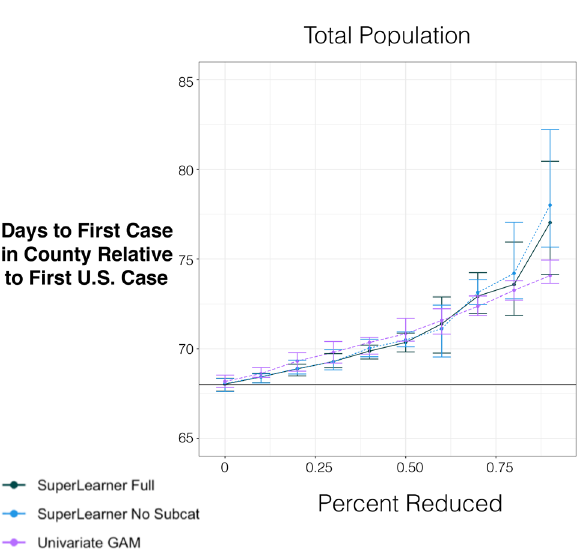
Figure 4. Marginal predictions of day of first case (relative to index time) for different proportional reductions of total population size for models adjusting for all other covariates, only covariates not in sub-category (see supplement Table S1) and